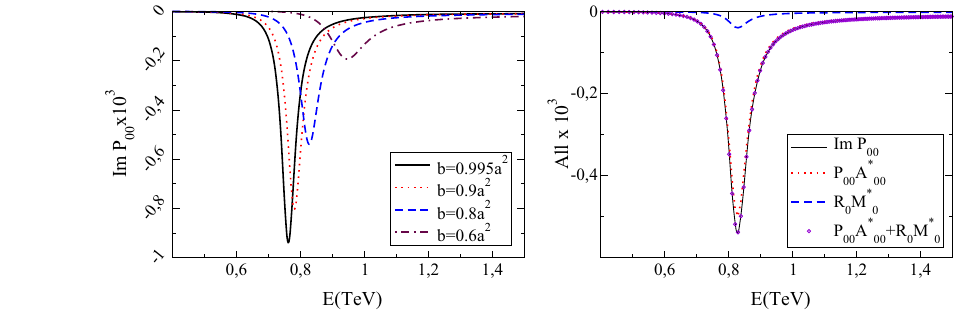
Fig. 7 Left The resonance of Fig. 3 is coupled to the hh with the strength ( b − a 2 ) indicated in the legend for each line, the other parameters remaining the same as earlier. Right Test of the unitarity relation in Eq. (54) for the case b = 0 . 8 a 2